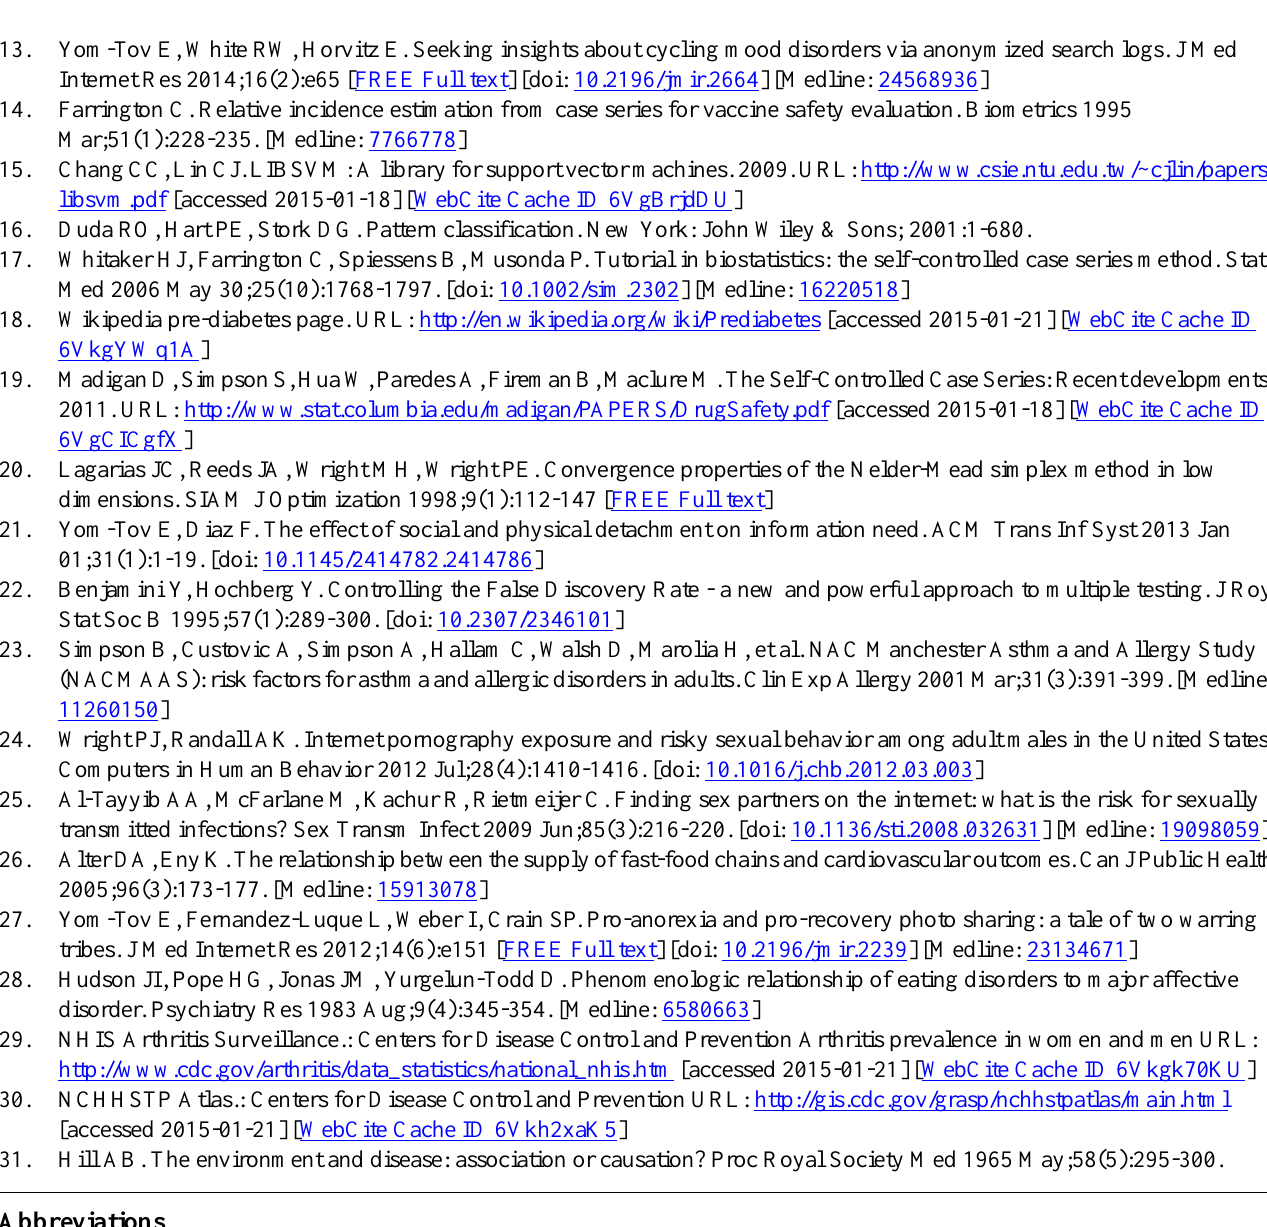
Abbreviations AIDS: acquired immune deficiency syndrome AUC: area under the curve FDR: false discovery rate HIV: human immunodeficiency syndrome ICD-10: International Classification of Diseases, Tenth